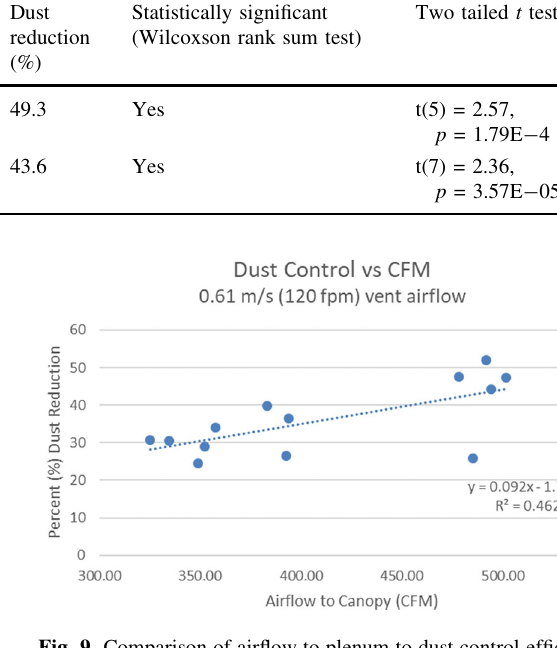
Fig. 9 Comparison of airflow to plenum to dust control efficiency of the CAC for the 120-fpm entry ventilation airflow Table 15 Summary of dust control efficiency at 10 in. below the canopy air